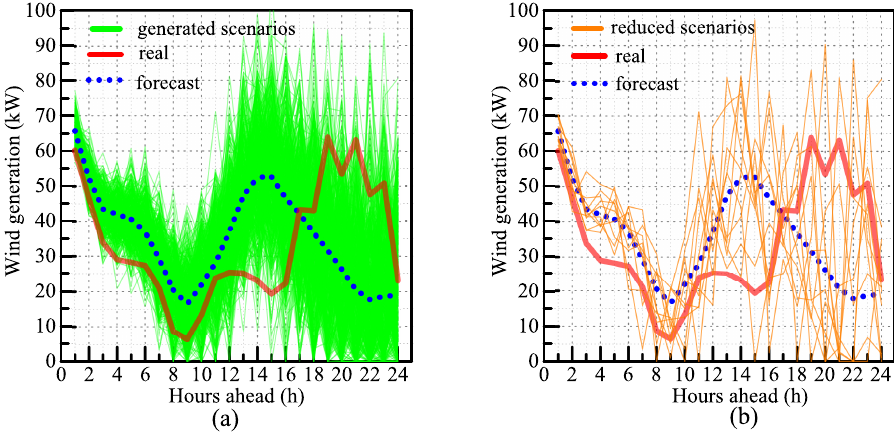
Figure 7. Scenario generation and reduction of aggregated wind power production ( a ) generated 500 wind scenarios for 24 h ahead with increasing standard deviation; ( b ) reduced set of 10 final scenarios by applying the BRA algorithm to the original 500